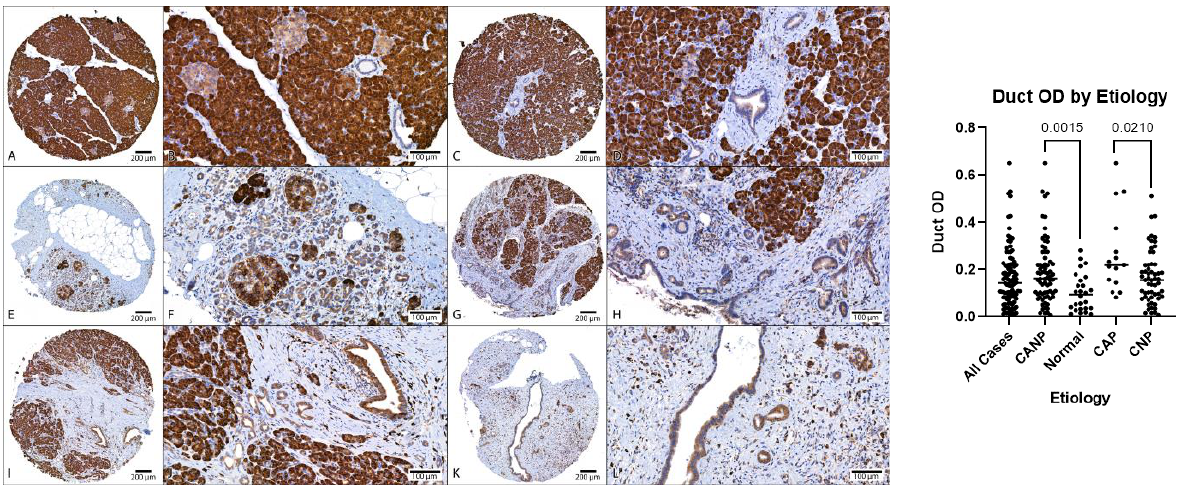
Figure 2. Comparison of MANF duct OD, DAB with hematoxylin counterstain. Left: ( A – D ) Representative normal pancreatic tissue (NPT) with duct OD averages of 0.10 and 0.06 (NPT average of 0.10). ( E – H ) Representative chronic non-alcoholic pancreatitis (CNP) with duct OD averages of 0.14 and 0.17, respectively (CNP cohort average of 0.17). ( I – L ) Representative chronic alcoholic pancreatitis (CAP) with duct OD averages of 0.38 and 0.25, respectively (CAP cohort average of 0.27). ( A , C , E , G , I , K ) at 40× magnification; ( B , D , F , H , J , L ) at 200× magnification. ( Right ): Dot plot of duct OD estimates, combined genders, with p -values displayed. OD, optical density; DAB, diaminobenzidine.